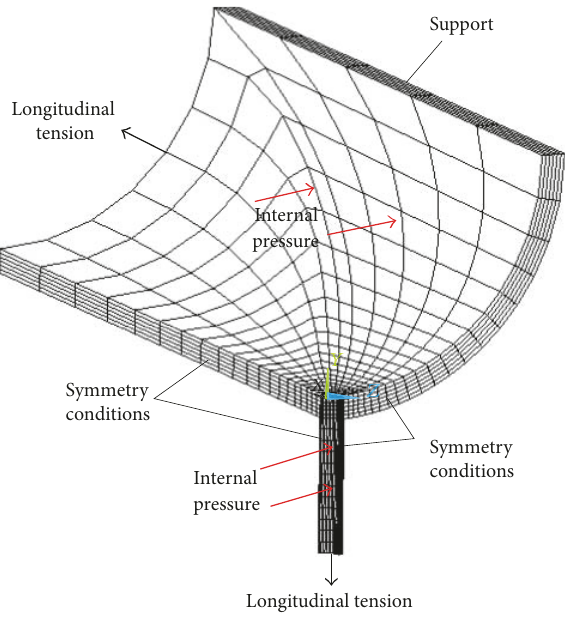
Figure 10: Division of the model of a cylindrical element with a nozzle into finite elements and the assumed boundary conditions.